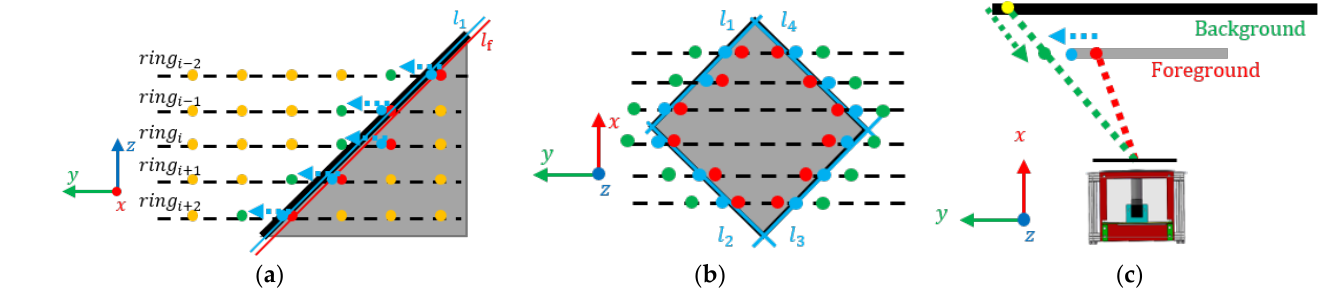
Figure 5. Illustration of edge points extraction. ( a ) is a partial view of ( b ), and ( c ) is a top view. Yellow points indicate the scanning points of LiDAR, red points indicate the edge points on the board, green points indicate the points projected to the board plane, and blue points indicate the improved points by the proposed method. The black dotted line is the scanning line of the LiDAR, the red line is fitted by the red points, and the blue line is fitted by the blue points.